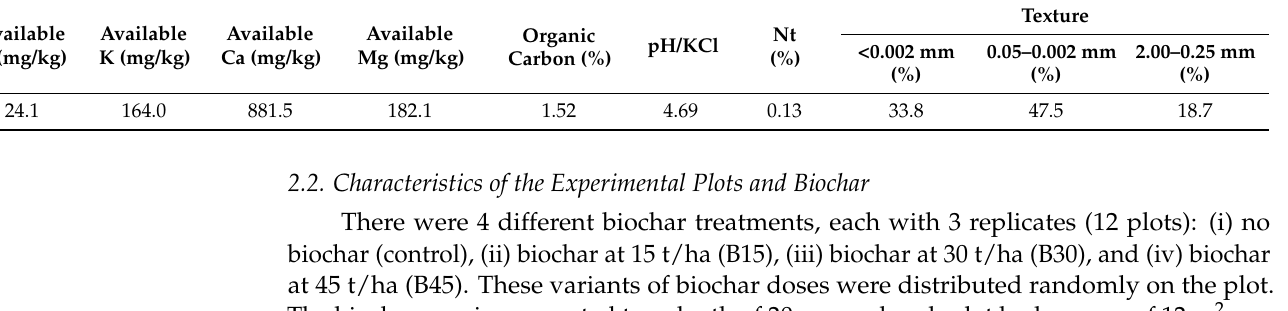
Table 1. Basic characteristics of the soil (sandy clay loam) in the experimental plots. These character- istics were measured before the experiment was